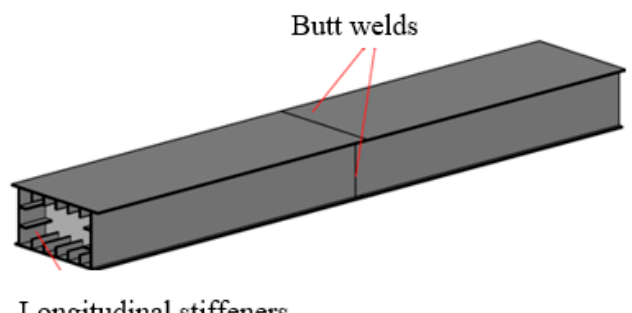
Figure 2. A 3D model diagram of steel box girder/unit: mm.